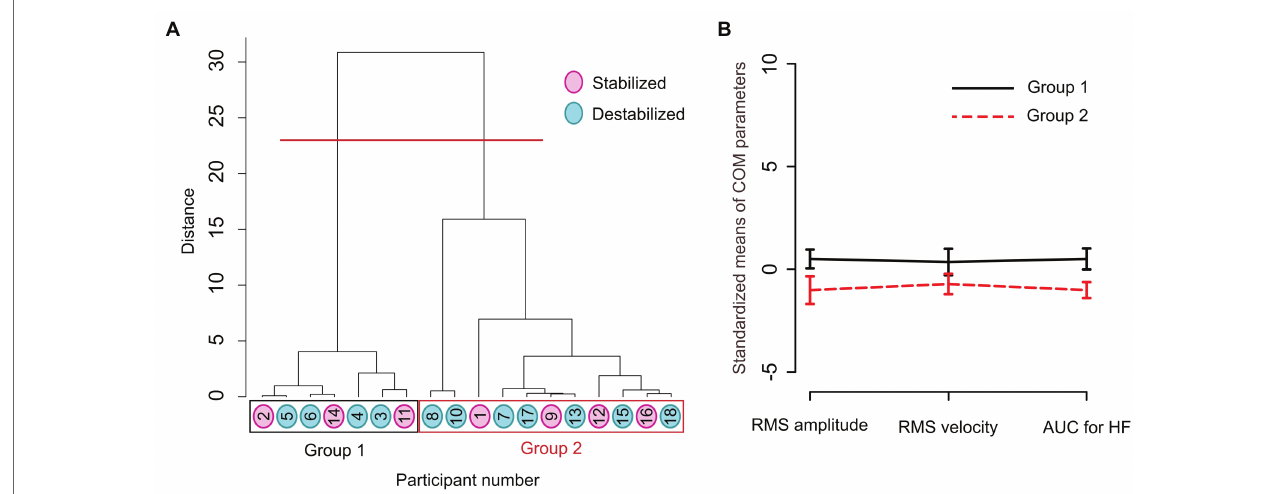
FIGURE 2 | (A) Dendrogram of the process of merging the units into groups with Ward’s hierarchical clustering method based on the amplitude, velocity, and frequency parameter of COM as features. Our clustering solution separated participants into 2 groups. Participants stabilized by the cart stabilization method are marked with pink and the destabilized participants are marked in blue. (B) Means and standard deviations of standardized (subtracted mean and multiplied by 1,000) COM parameters for two groups grouped by Ward’s hierarchical clustering